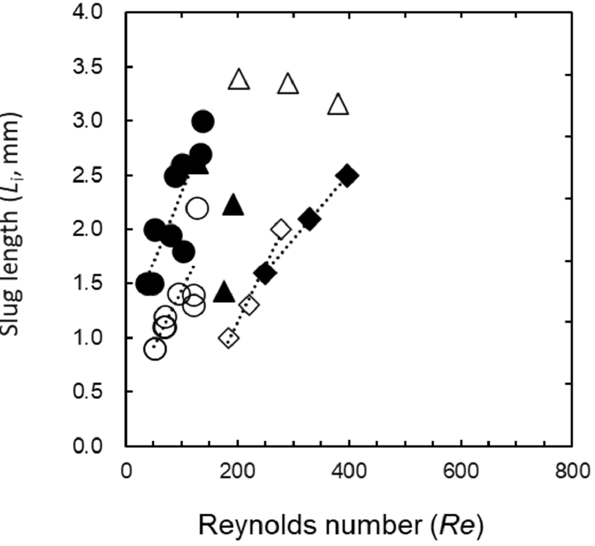
(cid:4) and • : 1 mm; and : 2 mm; (cid:52) and (cid:78) : 3 mm; open: (cid:35) (cid:51)